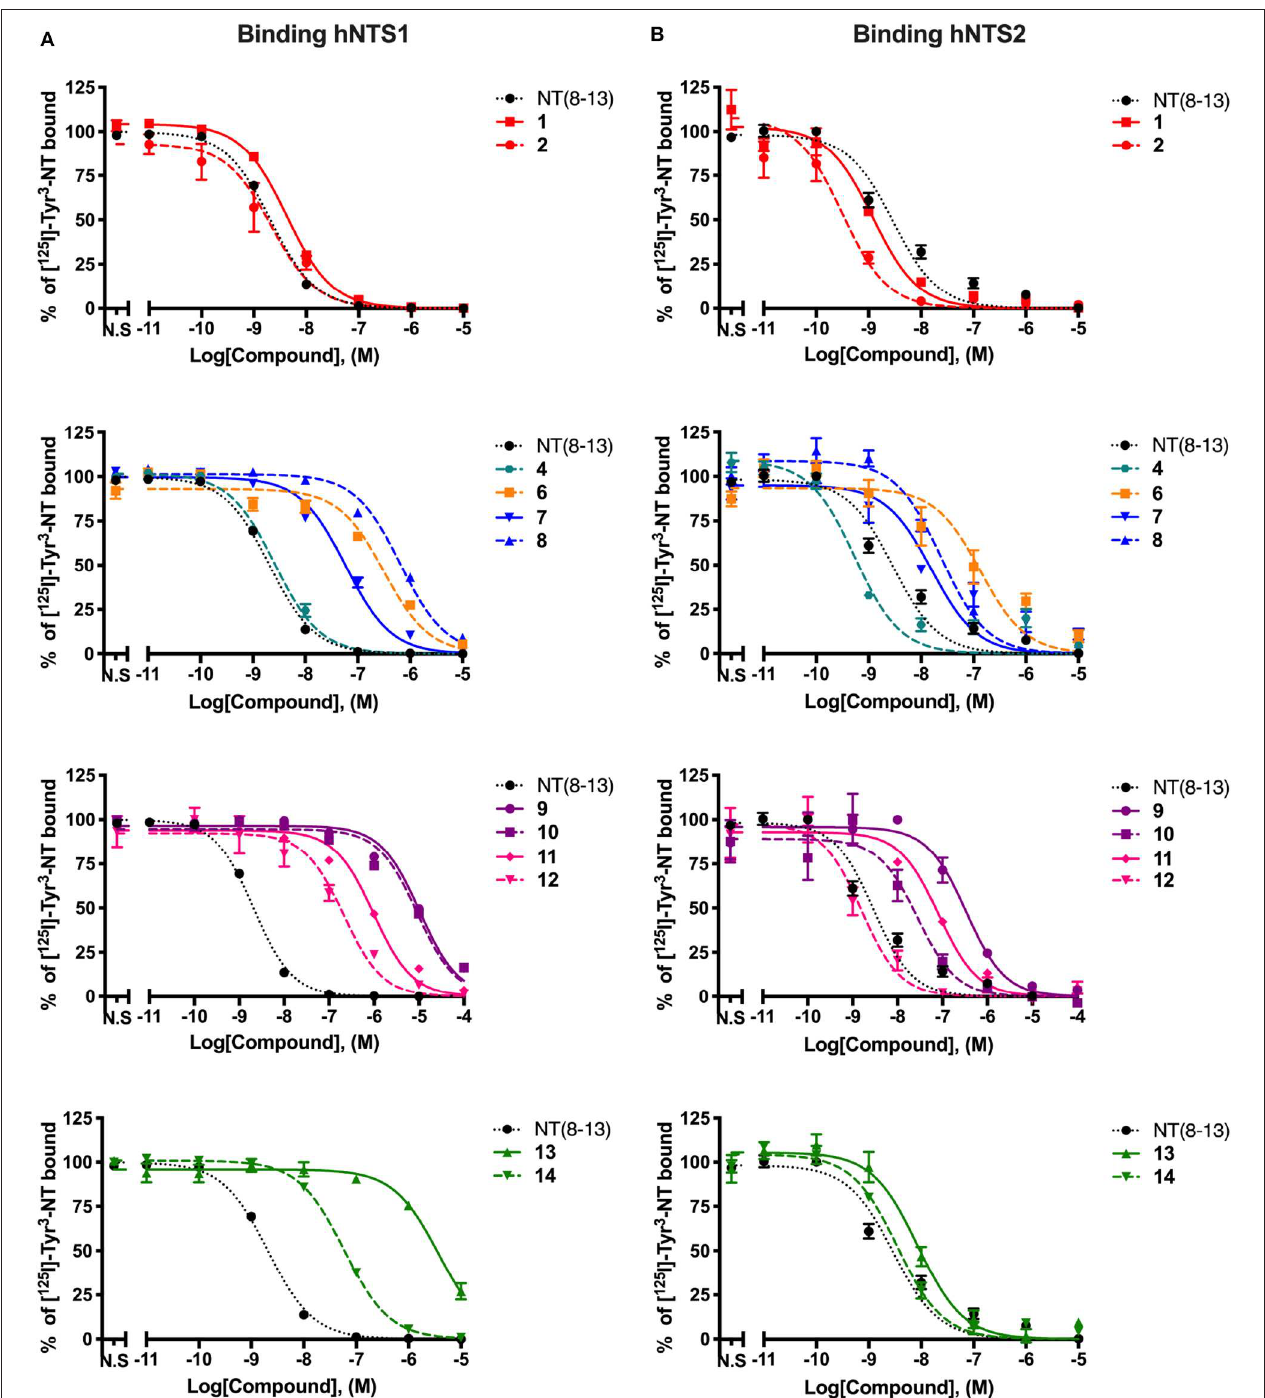
FIGURE 1 | Displacement curves of 125 I-[Tyr 3 ]-NT by a series of NT(8-13) analogs at the NTS1 (A) and NTS2 (B) binding sites. Data are expressed ± SEM of at least three separate experiments. For compounds 3 , 5 , 15 , and 16 , K i values were taken from the literature (Fanelli et al., 2015; Eiselt et al., 2019). plasma at 37 ◦ C ( Figure 2 ). The half-lives of these compounds are summarized in Table 2